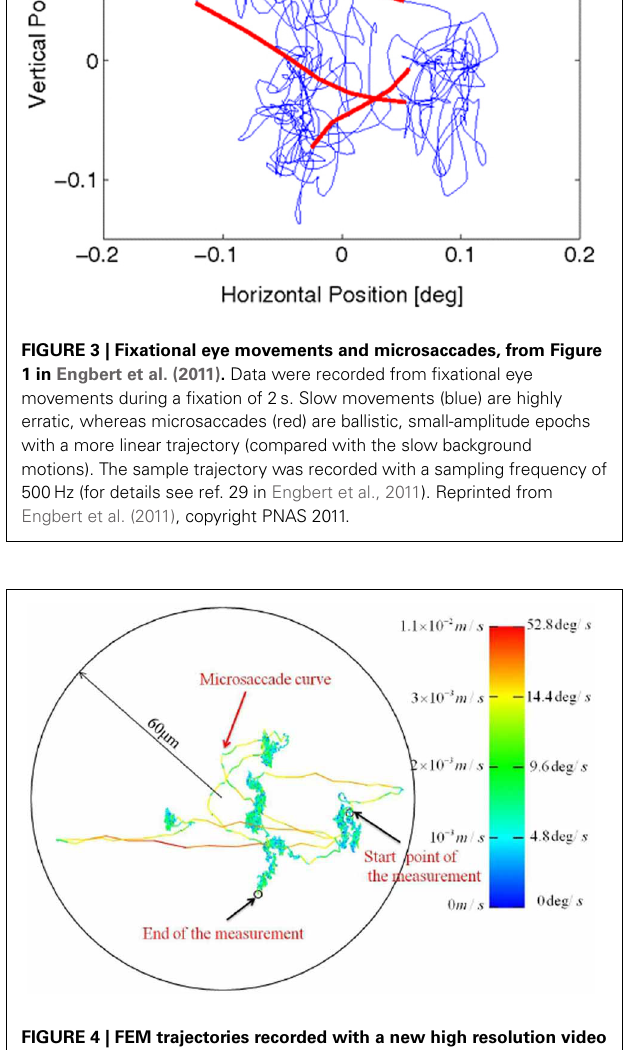
FIGURE 4 | FEM trajectories recorded with a new high resolution video tracking